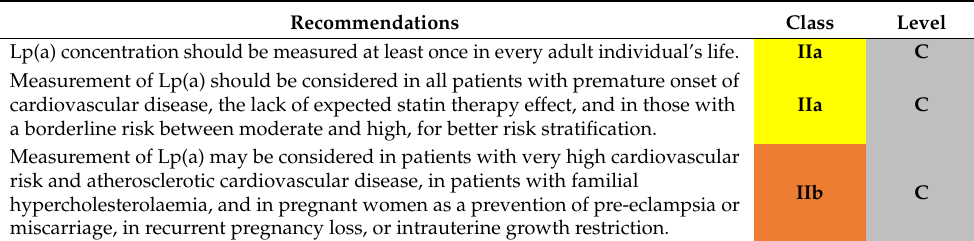
Table 3. Recommendations regarding the Lp(a) measurement